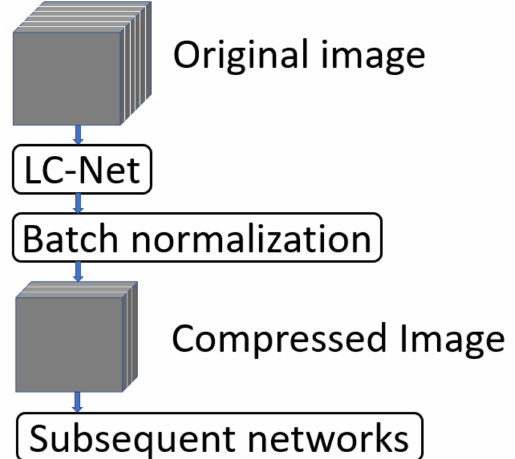
Figure 3. Apply LC-Net to the